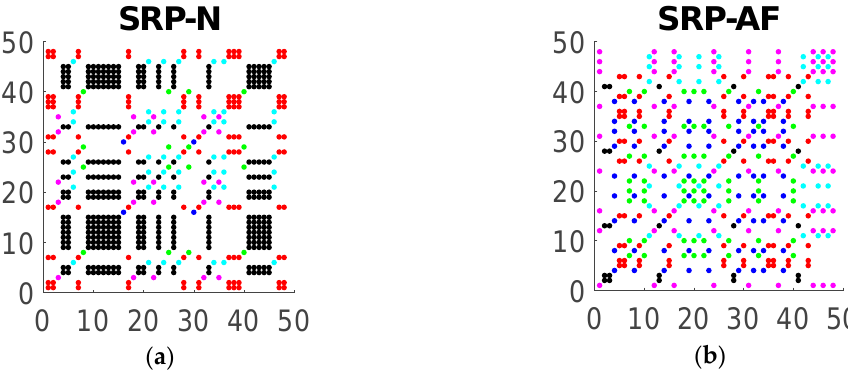
Figure 2. Symbolic recurrence plot (SRP) of heart beat interval RR for embedding dimension m = 3 in normal sinus ( a ) and atrial fibrillation ( b ). N denotes normal sinus and AF atrial fibrillation.